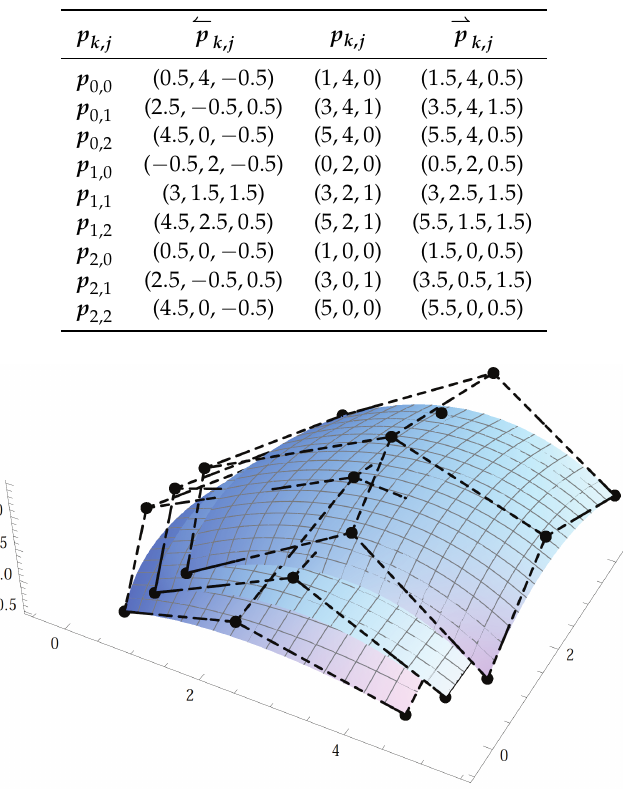
Figure 1. Fuzzy quadratic by quadratic patch.